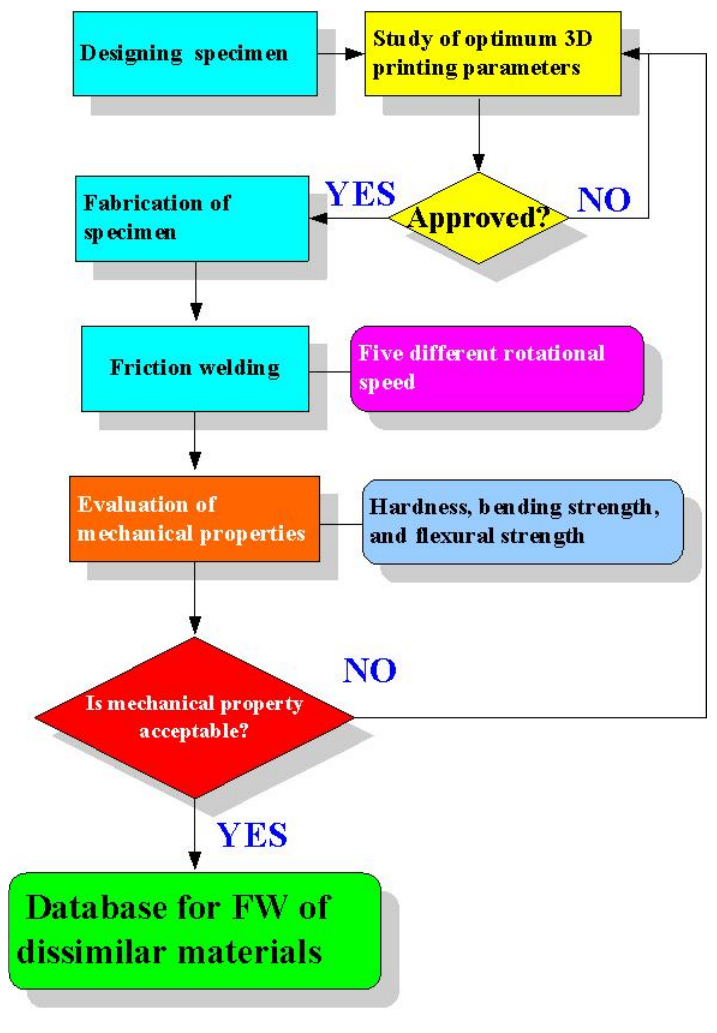
Figure 1. Flow diagram of the experimental methodology.